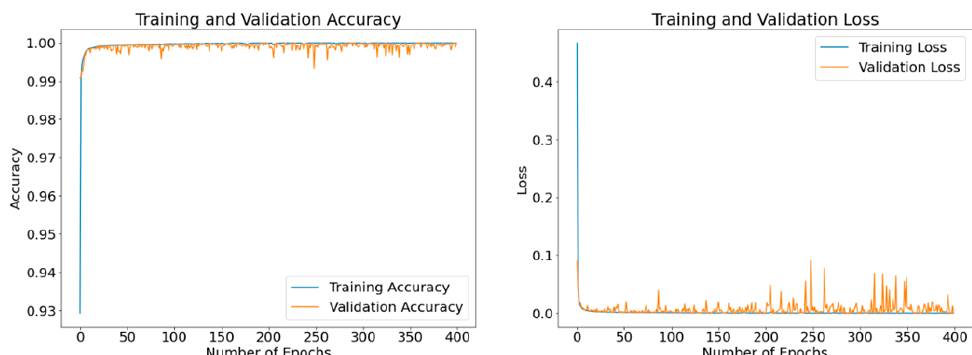
Figure 12. Accuracy and loss curves generated by Adam optimizer after model training (blue) and validation (orange). A batch size of 8 and 400 epochs are used.